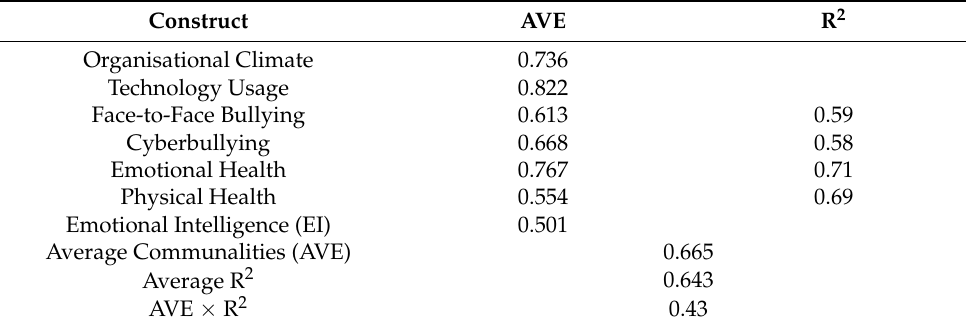
Table 5. Goodness-of-fit (GOF) index.